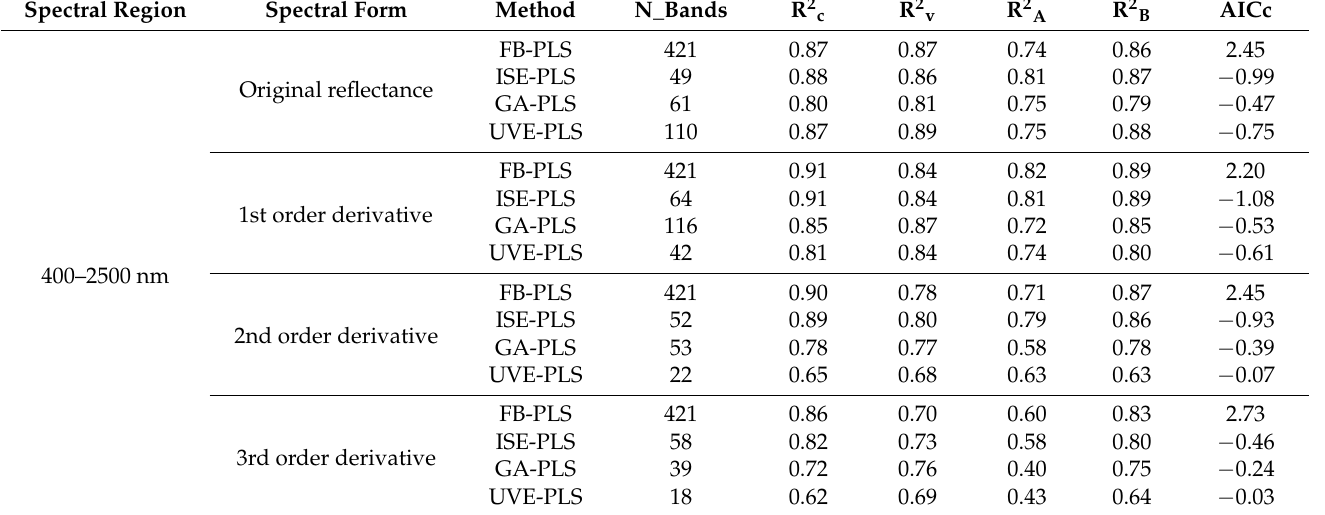
Table 4. PLSR model performance in estimating LNC from spectra within different spectral